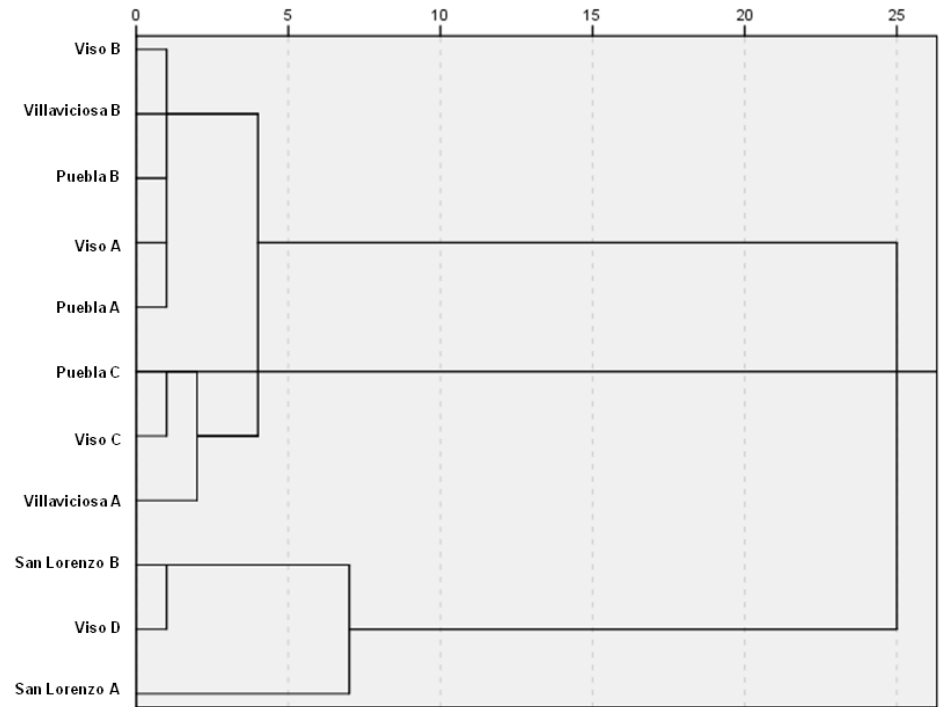
Figure 3. Agglomerative cluster analysis based on the Ward method.